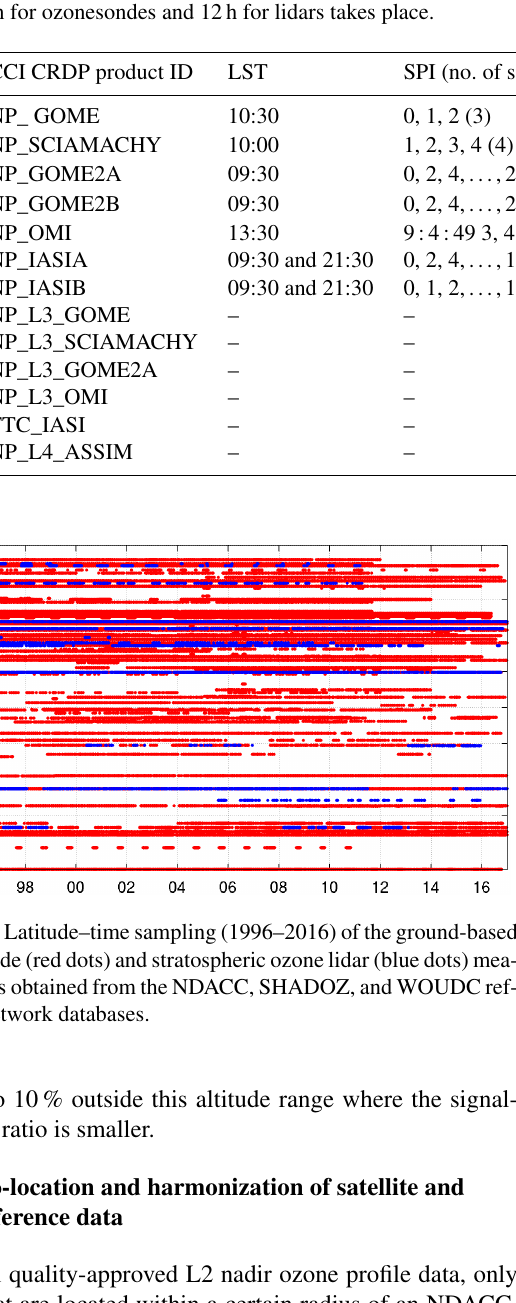
Table 4. Local solar time (LST), possible scan pixel indices (SPI, with number of pixels per scan between brackets), ground pixel size, co- location distance, and temporal range of the comparative analysis. The asterisk with the Metop-B instruments indicates that the corresponding time series are not sufficiently long for drift studies. Next to the spatial co-location, a selection of the closest satellite measurement in time within 6h for ozonesondes and 12h for lidars takes place.